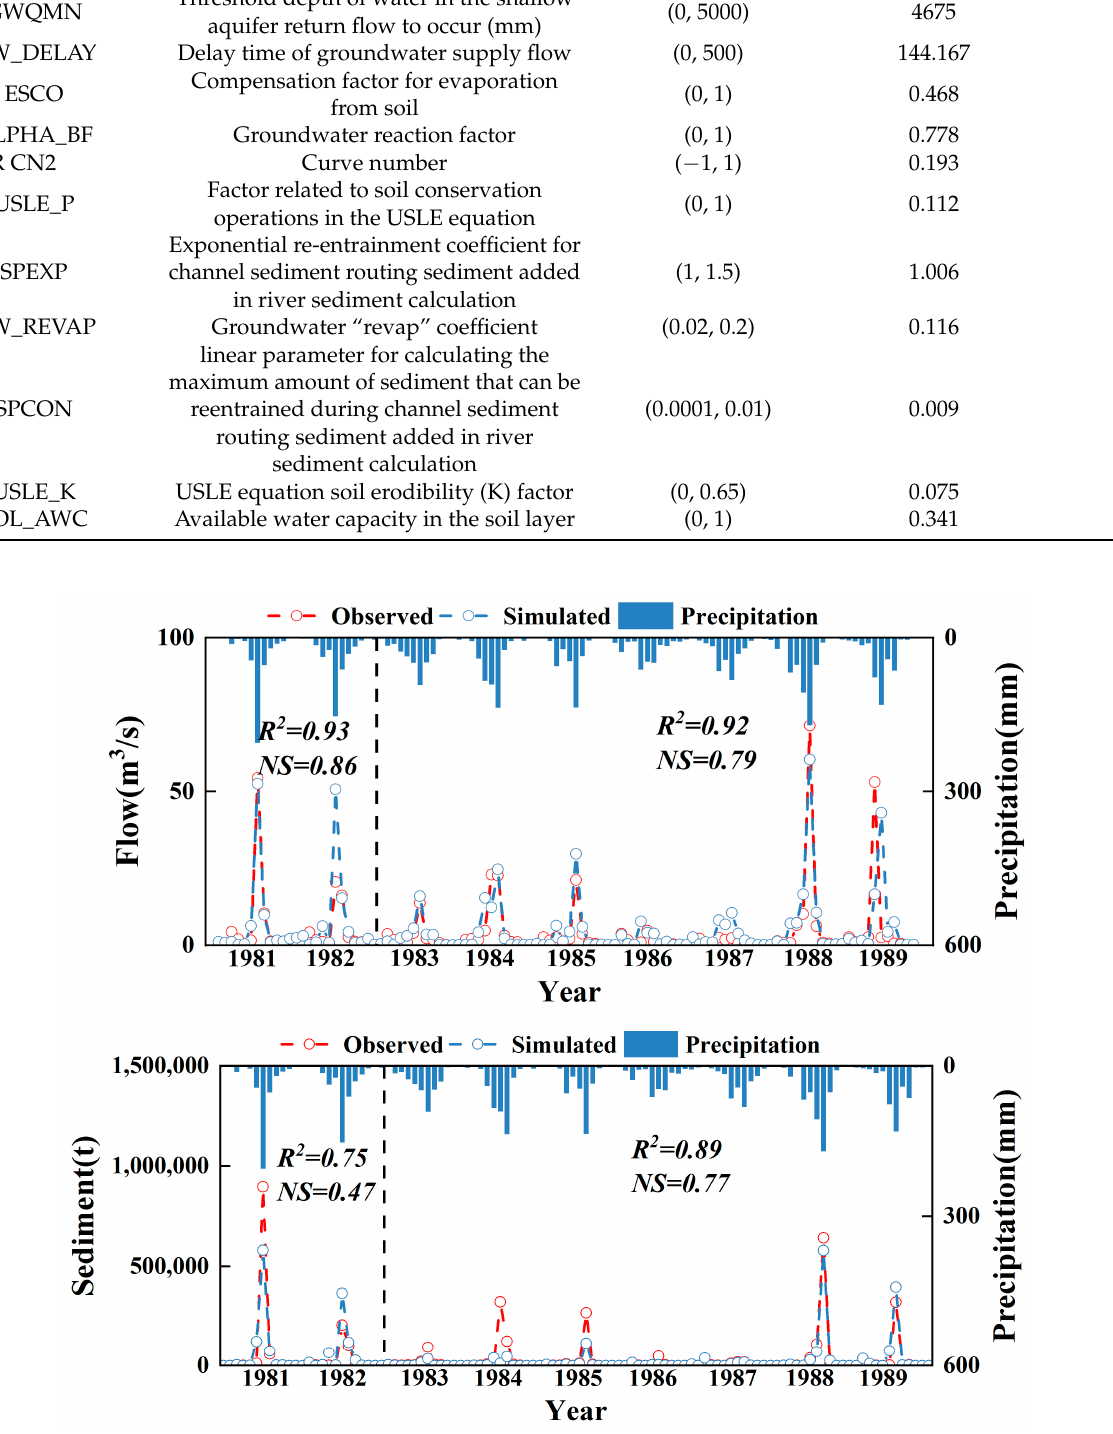
Figure 7. Observed and simulated monthly runoff and sediment load during the calibration and validation period.